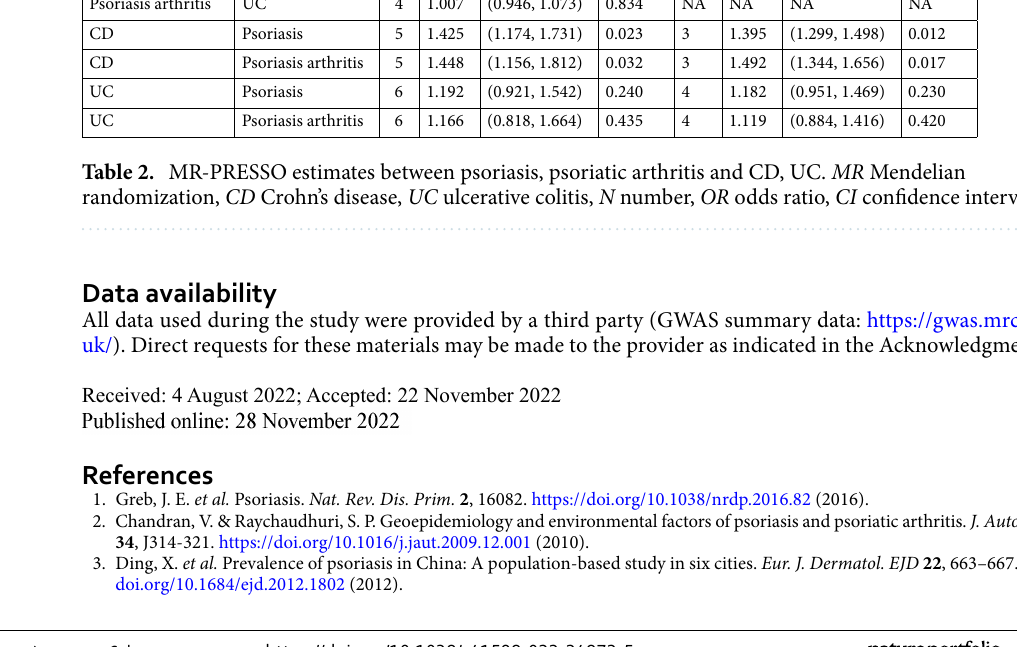
Exposure Outcome